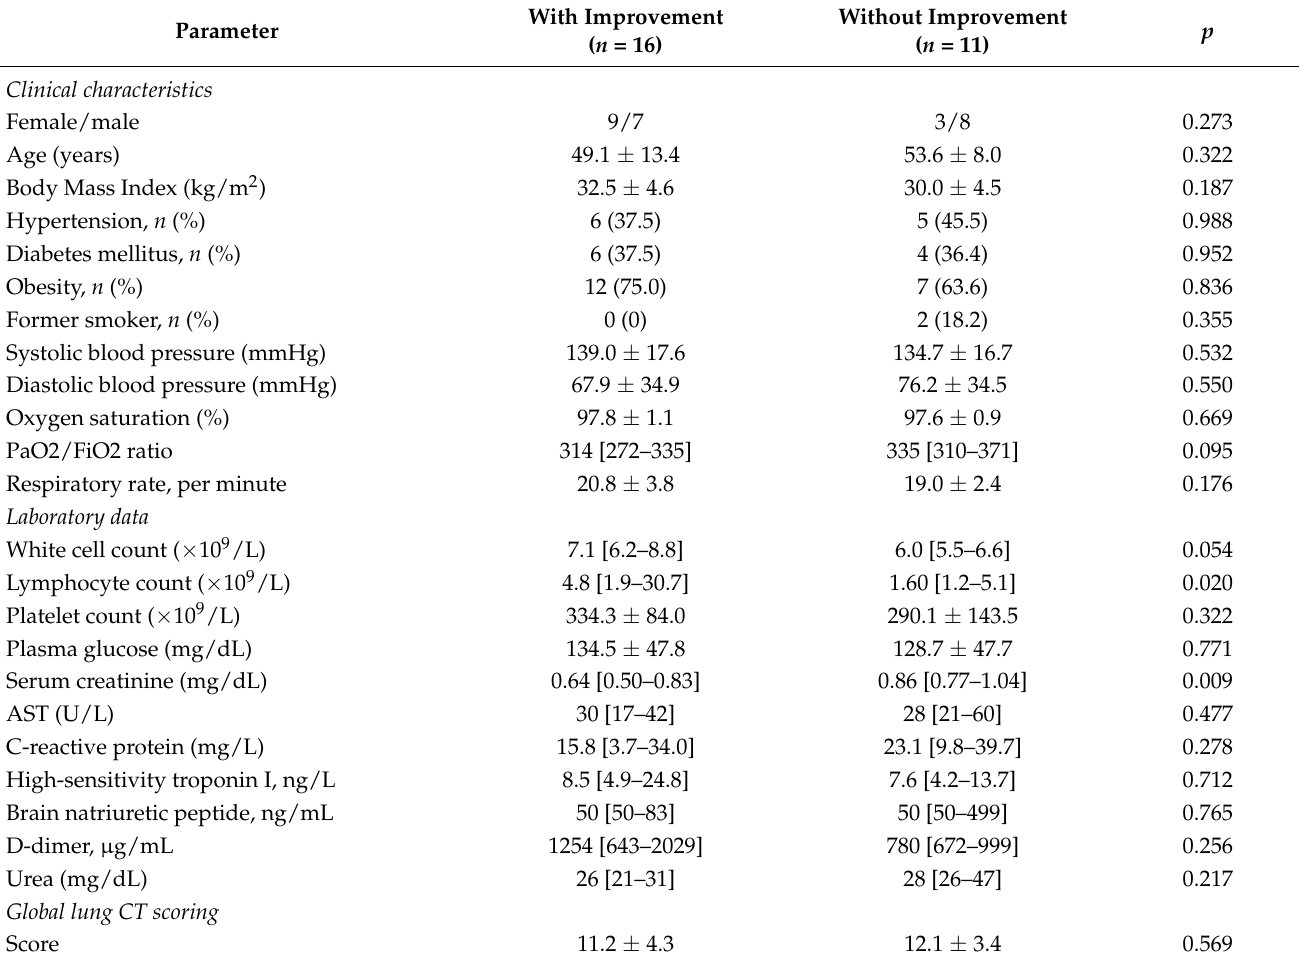
Table 1. Characteristics of participants at discharge according to radiological pulmonary